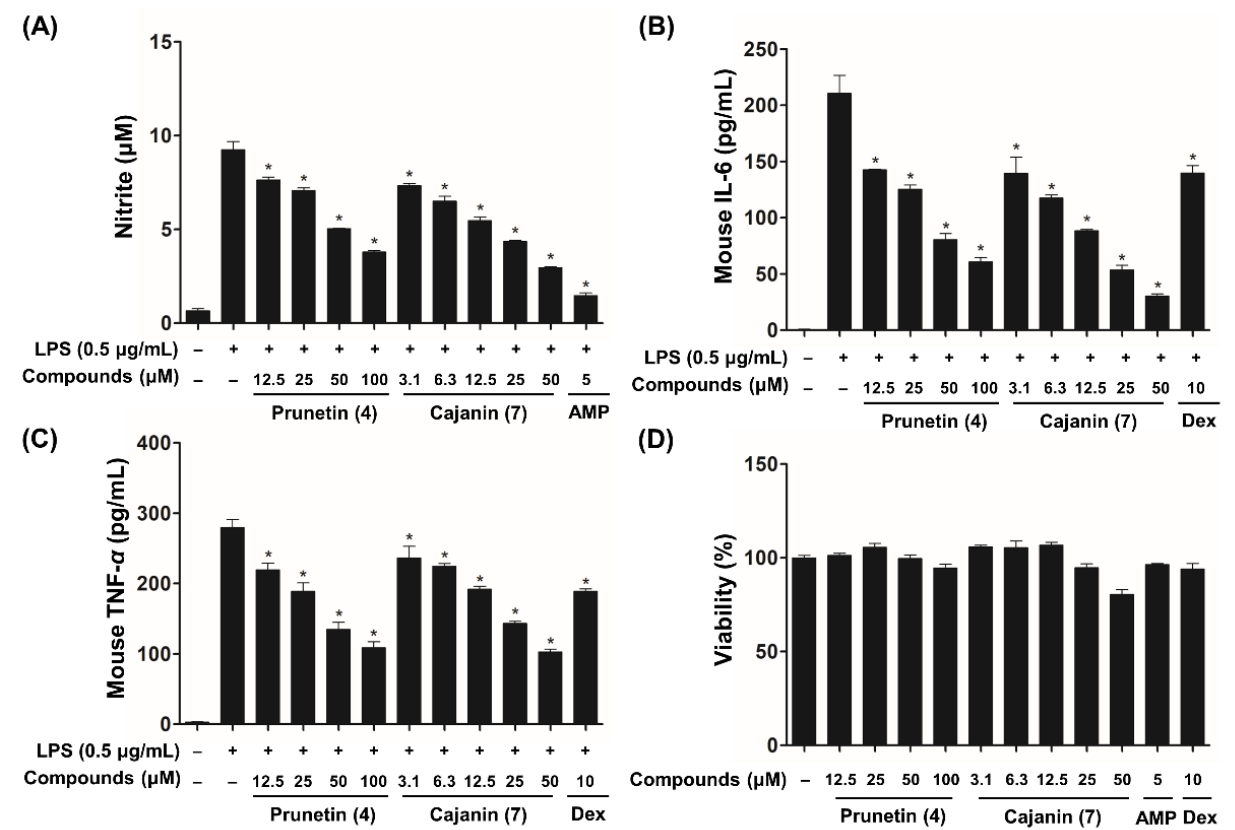
Figure 3. Effects of prunetin ( 4 ) and cajanin ( 7 ) on the inflammatory mediators NO ( A ), IL-6 ( B ), and TNF- α ( C ) in LPS-stimulated RAW264.7 macrophages. NO, IL-6, and TNF- α secretion was measured by NO and ELISAs as described in the Materials and Methods. Cytotoxicity was not observed at the IC 50 concentrations of prunetin ( 4 ) and cajanin ( 7 ) ( D ), and all data are expressed as the mean ± SEM of three independent experiments. Statistical significance was considered at * p < 0.05 compared to the LPS-only treatment group. 2-Amino-4-methylpyridine (AMP) and dexamethasone (Dex) were employed as positive controls.